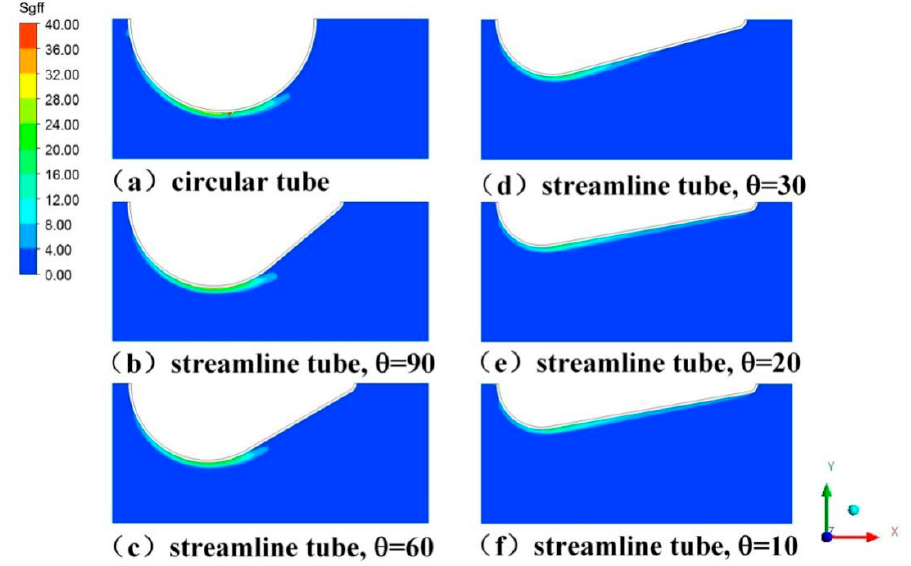
Figure 10. Local Sg ff distribution around the tube at di ff erent